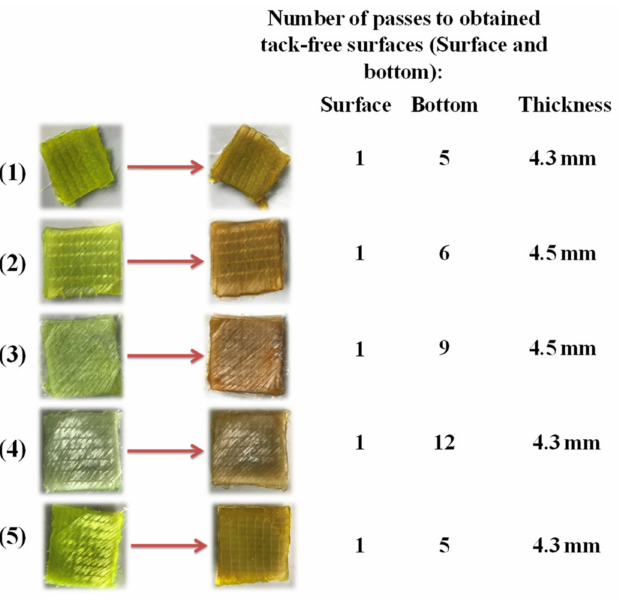
Figure 4. Photocomposites produced by FRP experiments of acrylate monomer (TA) using a LED conveyor @395 nm Napht/Iod/NPG (0.05%/1%/1% w/w/w ): (1) Napht-1, (2) Napht-2, (3)